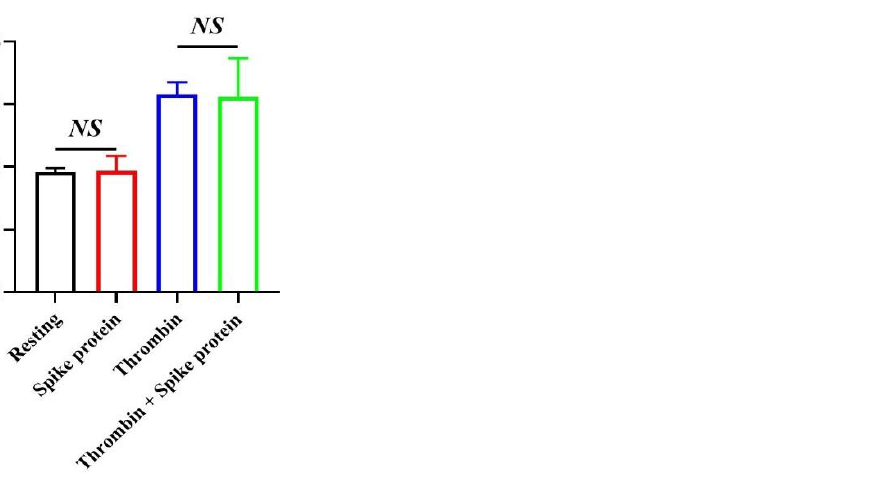
Figure A1. Spike protein does not affect platelet apoptosis. Platelets were preincubated with Spike protein at 2 µ g/mL for 10 min and stimulated with thrombin (1 U/mL) for 30 min or not, then incubated with Annexin V antibody, platelet apoptosis was assessed by using flow cytometry ( n = 3). NS : no significant difference between two group.